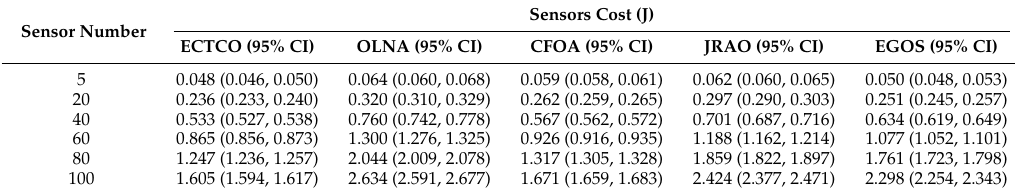
Figure 4. Sensors cost of different algorithms. Table 3. Sensors cost versus sensor